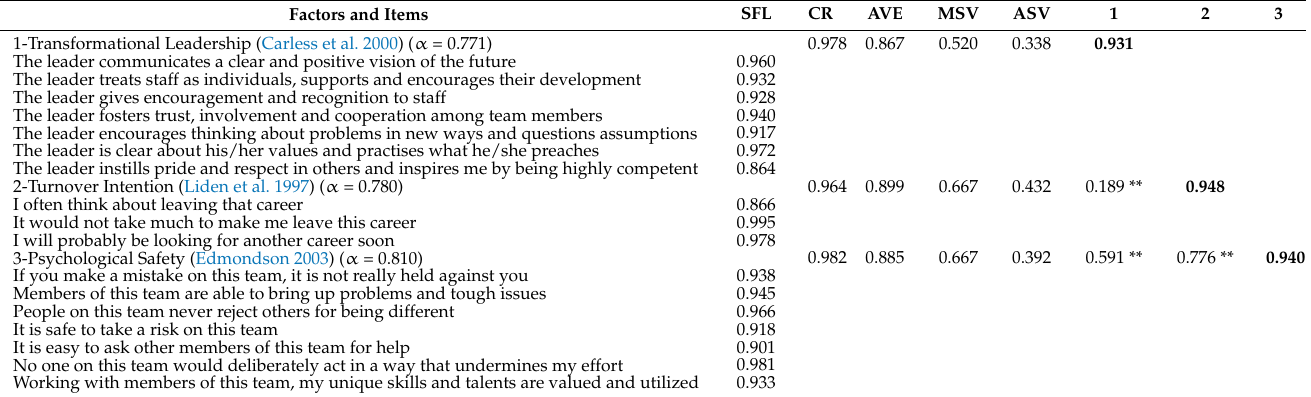
Table 2. The results of convergent and discriminant validity (developed by